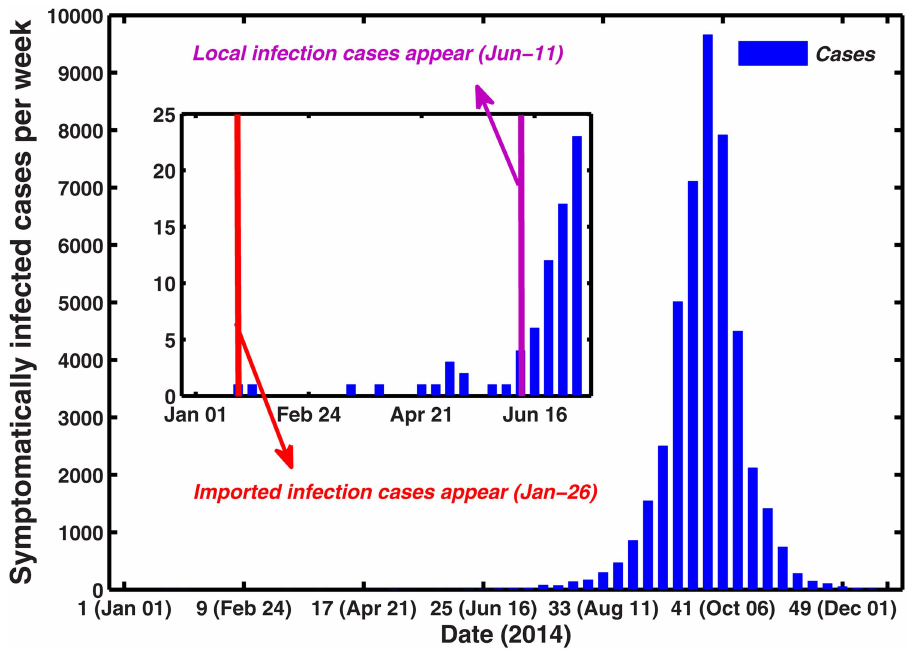
Fig 1. Number of dengue cases reported in Guangdong province, China, 2014.